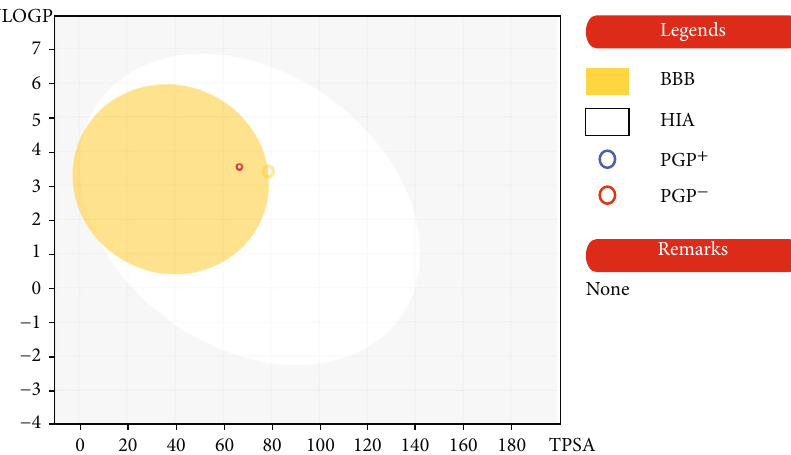
Figure 5: Predicted human intestinal absorption and blood brain permeability as per BOILED EGG diagram of compound